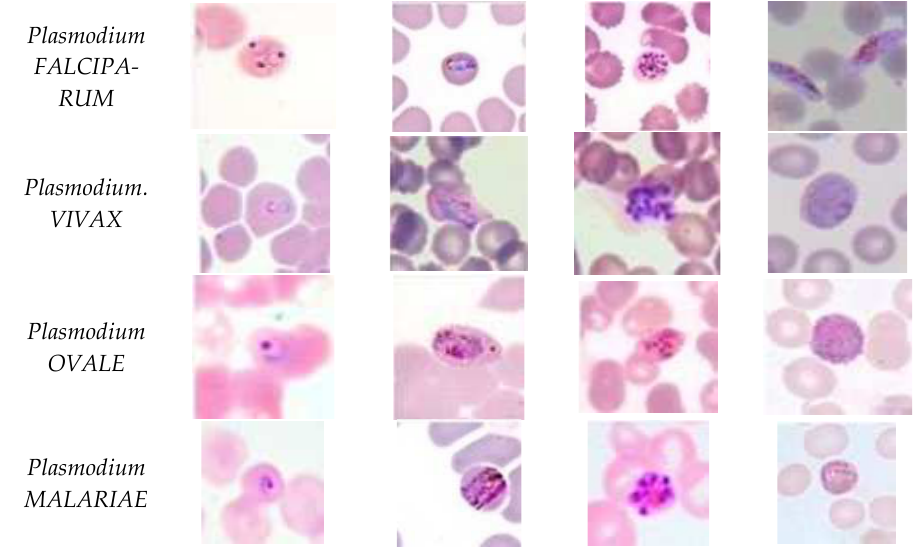
Figure 2. Malaria parasites and stages of